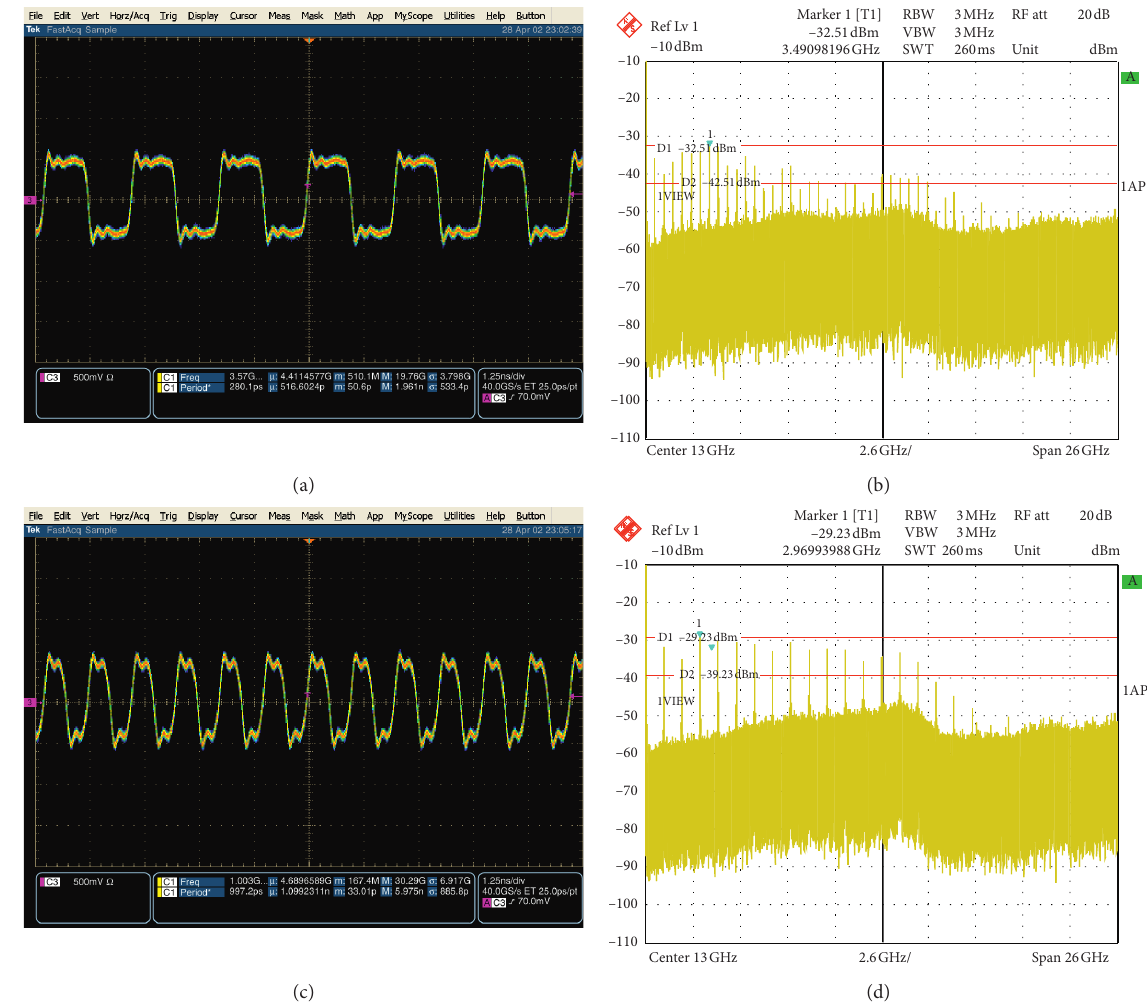
Figure 6: Results of the MFC generated by the square wave signal modulation. (a) and (c) are the 0.5GHz and 1GHz square wave signals, respectively. (b) and (d) are the generated MFC with the modulation of 0.5GHz and 1GHz square wave signals,